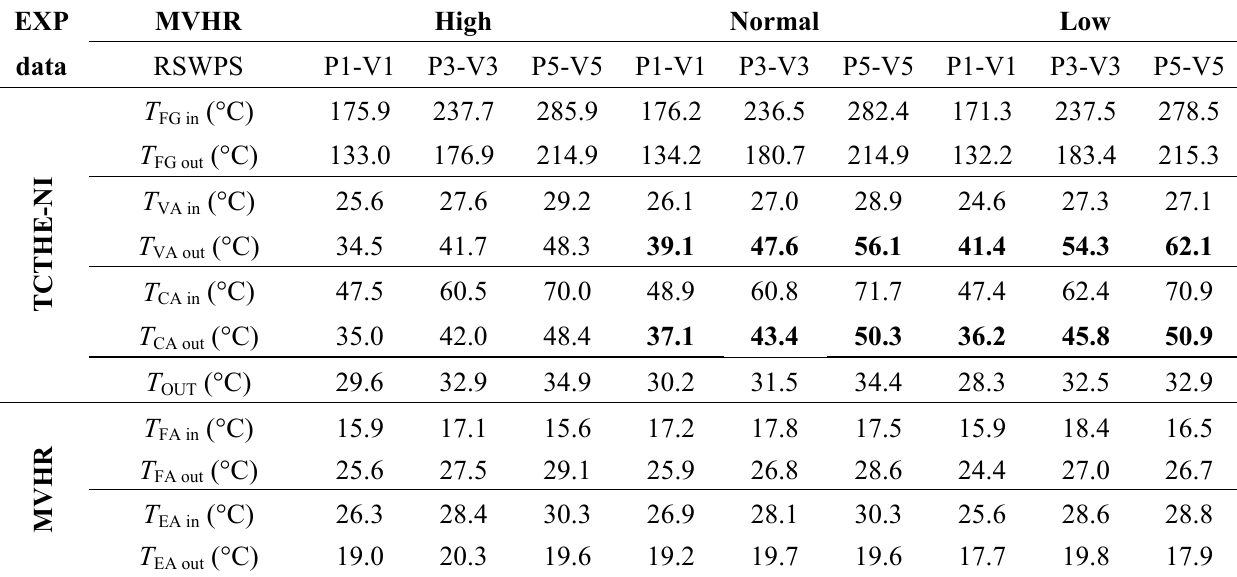
Table 5. Inlet and outlet temperatures of each fluid within the TCTHE-NI and the MVHR unit.